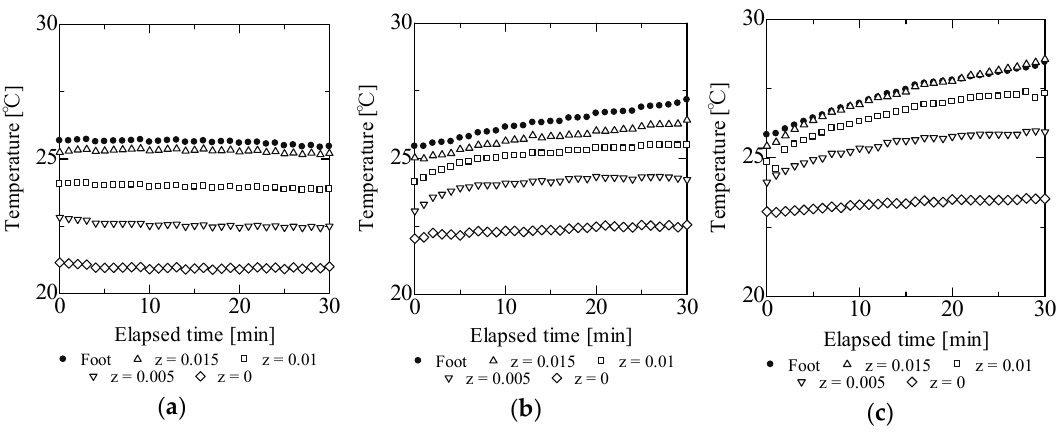
Figure 5. Measured time-dependent temperature distributions for the EVA08 material at 25 °C: ( a ) 0 beats/min gait frequency (seated position); ( b ) 45 beats/min gait frequency; ( c ) 75 beats/min gait